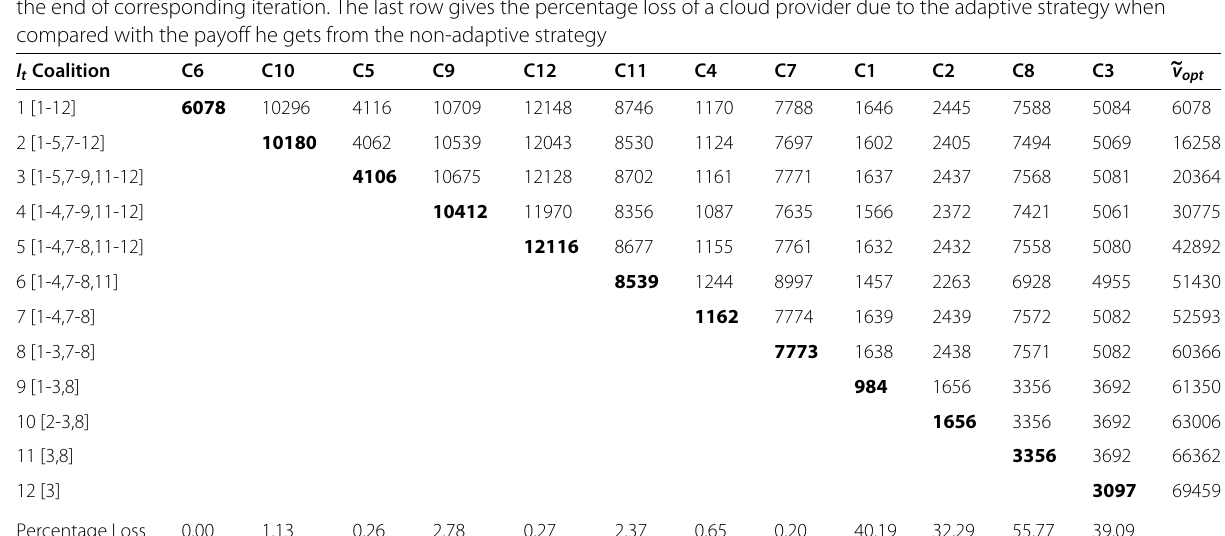
algorithm is (cid:7)( n 2 n ) . This makes the algorithm practical to implement when compared with the naive algorithm with time complexity (cid:7)( n ! ) .